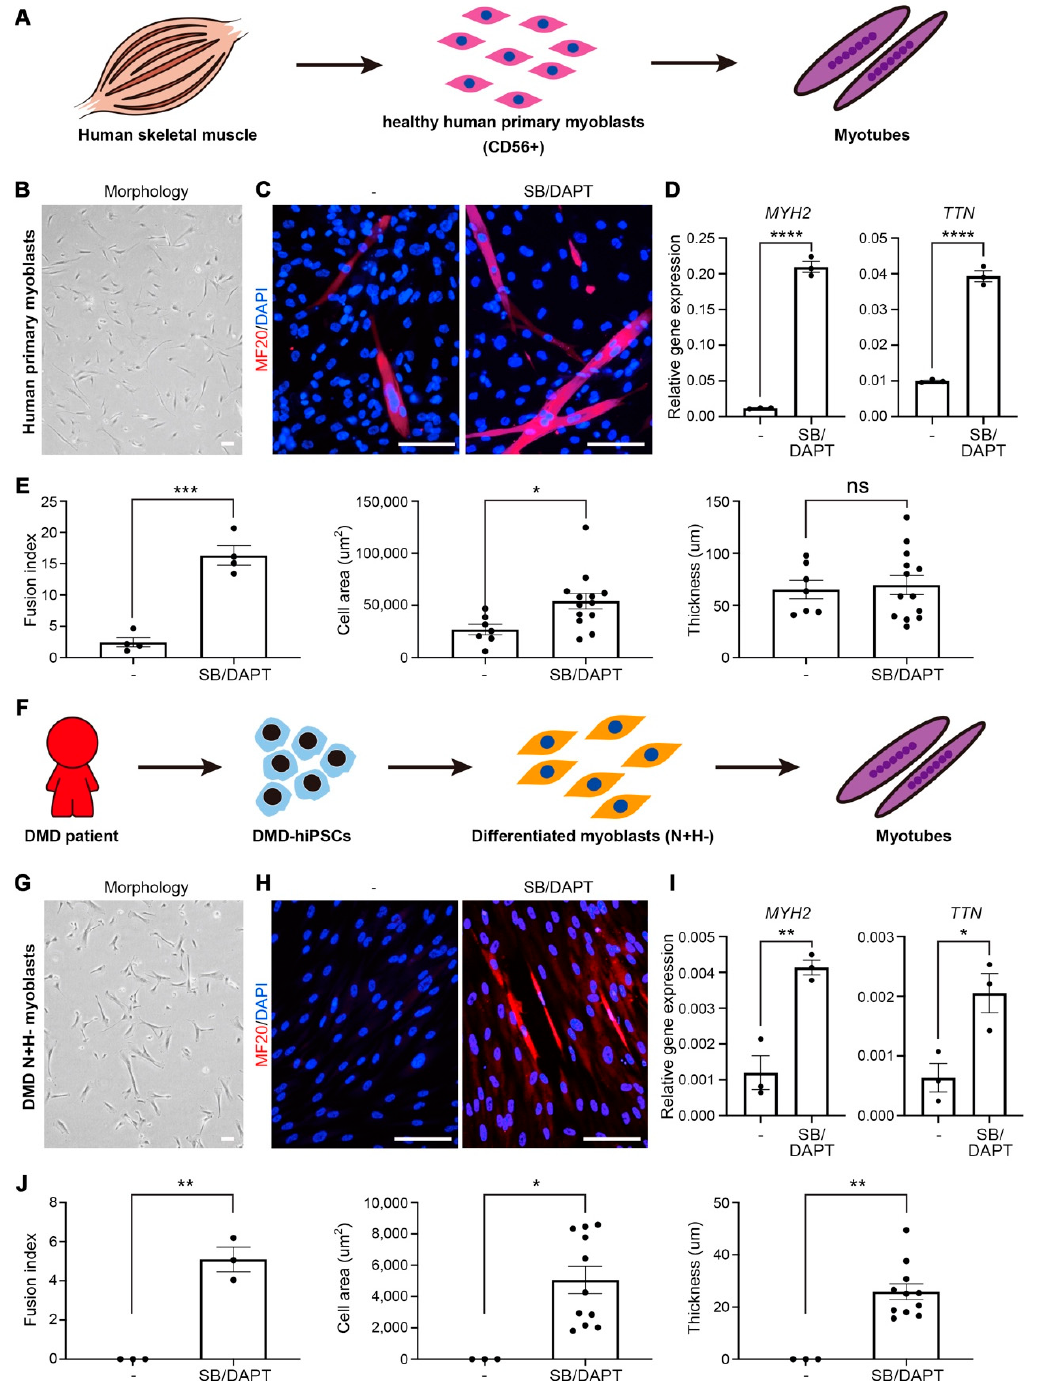
Figure 5. Myotube formation of primary myoblasts from healthy human skeletal muscle and NCAM+/HNK- myoblasts from DMD patient iPSCs with 2 small molecules. ( A ) Schematic illustration of the myotube formation process from human skeletal muscle to in vitro myotube formation. ( B ) A representative image of healthy human primary myoblasts. ( C ) Immunofluorescence image of MF20-stained myotubes by primary myoblasts with or without two small molecules. ( D ) Relative mRNA expression levels of myotube relative marker genes. ( E ) Fusion index, cell area, and thickness of myotube formation from primary myoblasts. ( F ) Schematic illustration of the myotube formation process from DMD patient to in